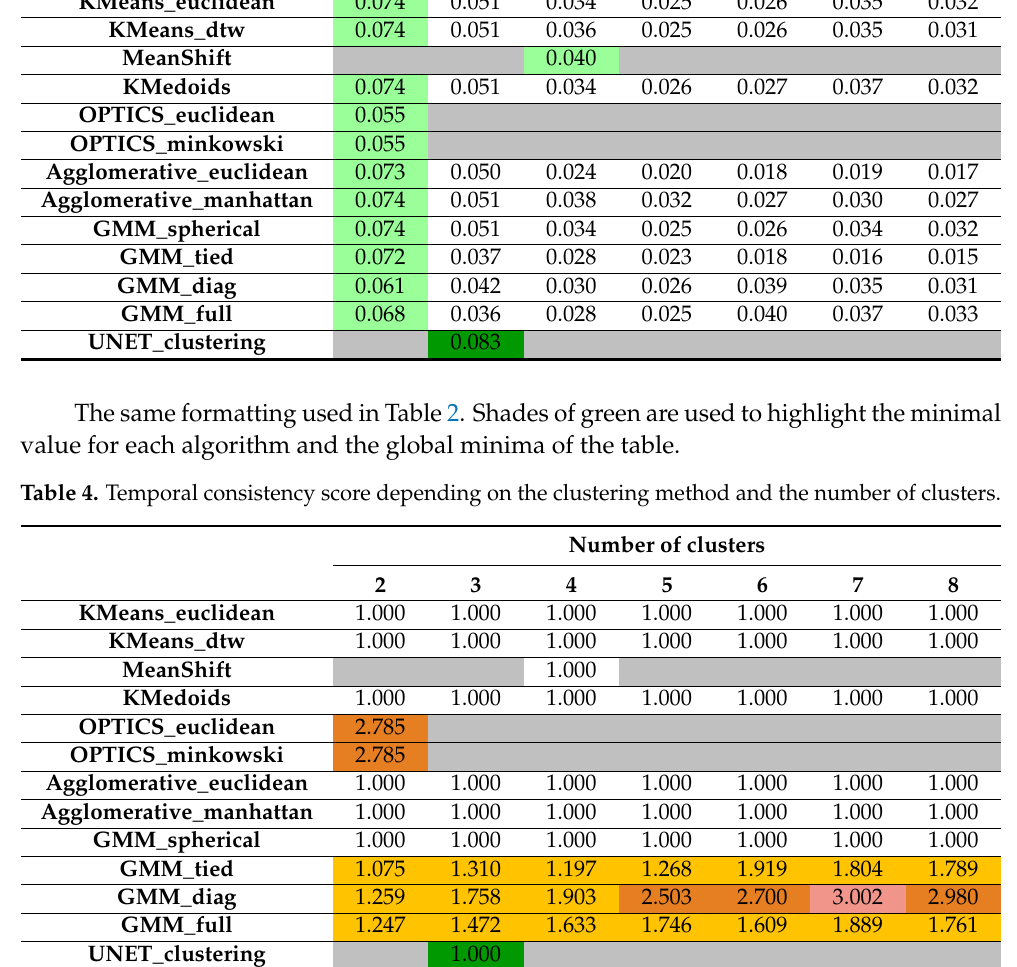
(cid:16) (cid:17) max y j − min y j depending on the clustering method and the number of